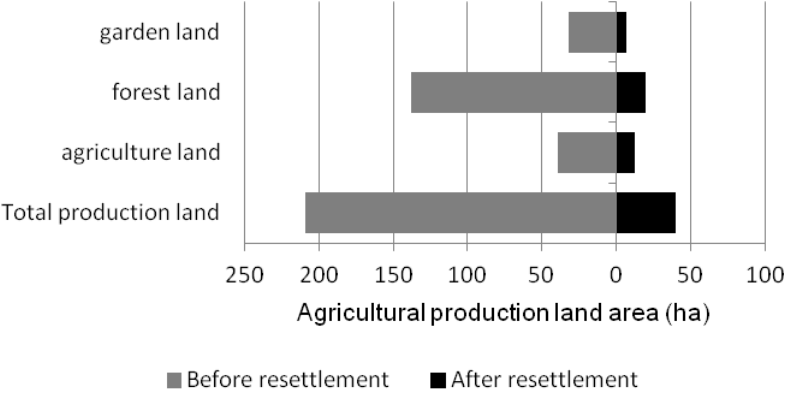
Figure 2. Production land of households in A Den village before and after resettlement ( n = 60). Source: Authors’ household survey,